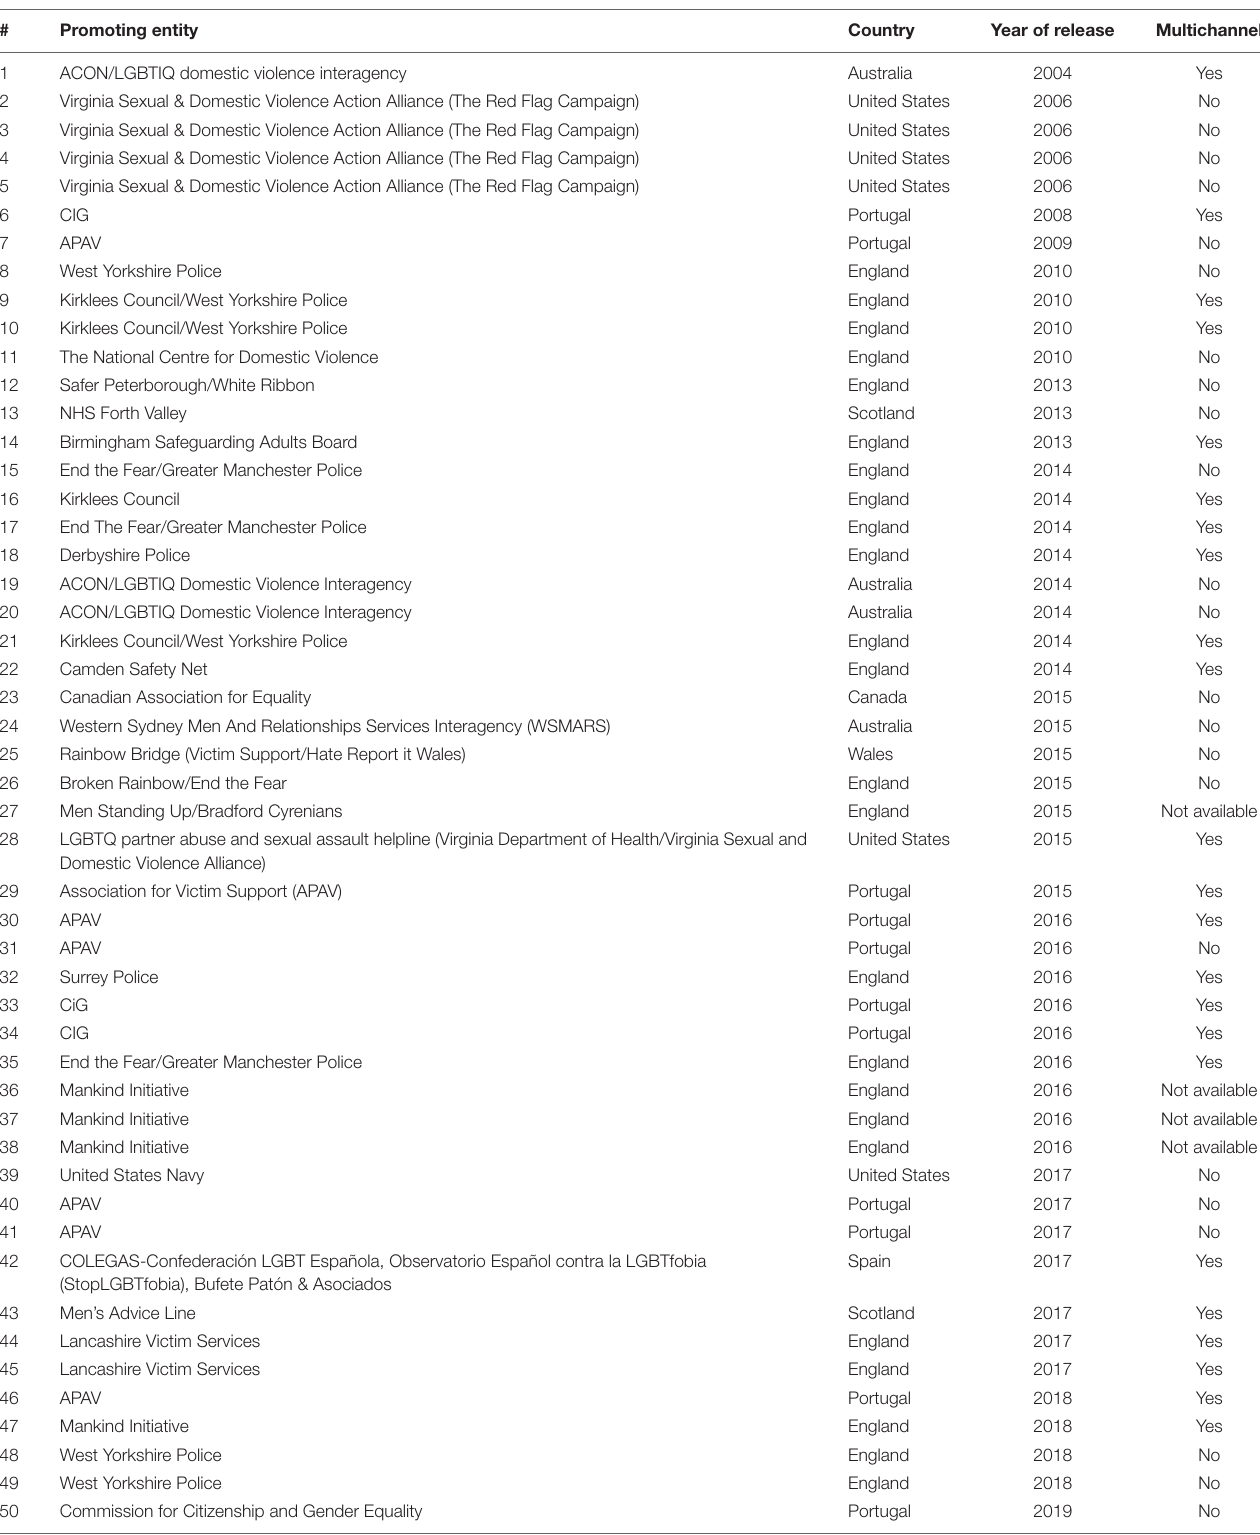
TABLE 1 | Campaign characteristics